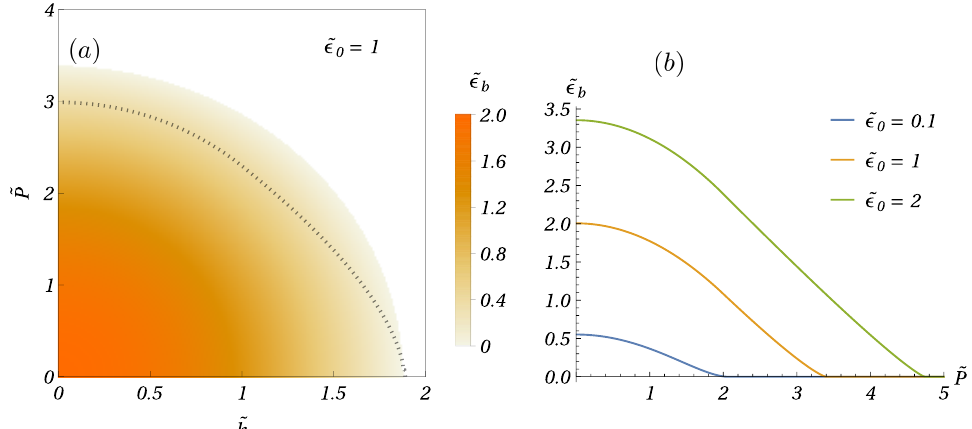
Figure 4: Effect of finite center-off-mass momentum P on dimer formation. Orange color in panel (a) indicates the range for dimensionless parameters quantifying the COM-momentum magnitude [ ˜ P ≡ | P | / ( m λ ) ] and the Zeeman energy [ ˜ h ≡ h / ( m λ 2 ) ] within which a 2D-fermion bound state exists. The color scale represents the dimen- ≡ ε / ( m λ 2 ) . The dotted black curve delimits the region sionless binding energy ˜ ε b b < E abs ≤ E rel of absolute bound-state stability where E , with the threshold energies b th th defined in Eqs. (21) and (22). Data shown in panel (a) are obtained for a fixed value ≡ ε / ( m λ 2 ) = 1 of the dimensionless interaction strength. Panel (b) shows plots ˜ ε 0 0 of ˜ ε as a function of ˜ P for selected values of ˜ ε and fixed ˜ h = b 0